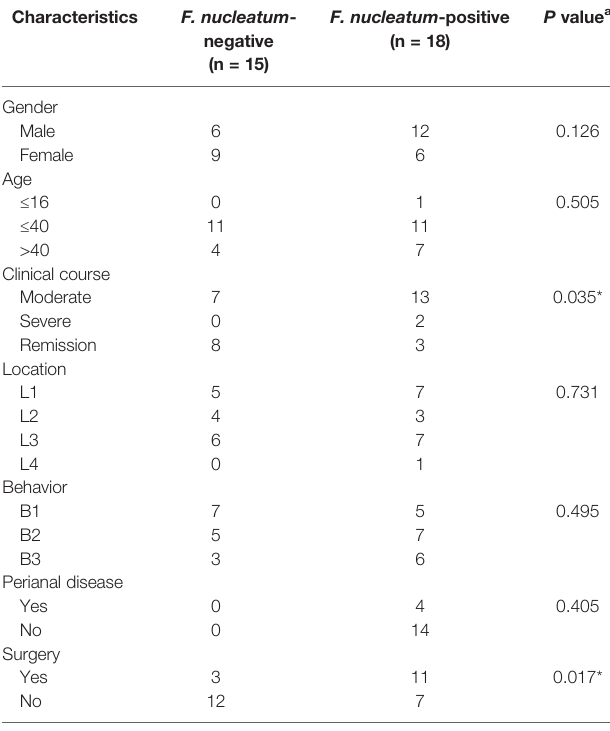
TABLE 1 | Clinicopathologic characteristics in Fusobacterium. nucleatum - negative vs. F. nucleatum -positive CD.